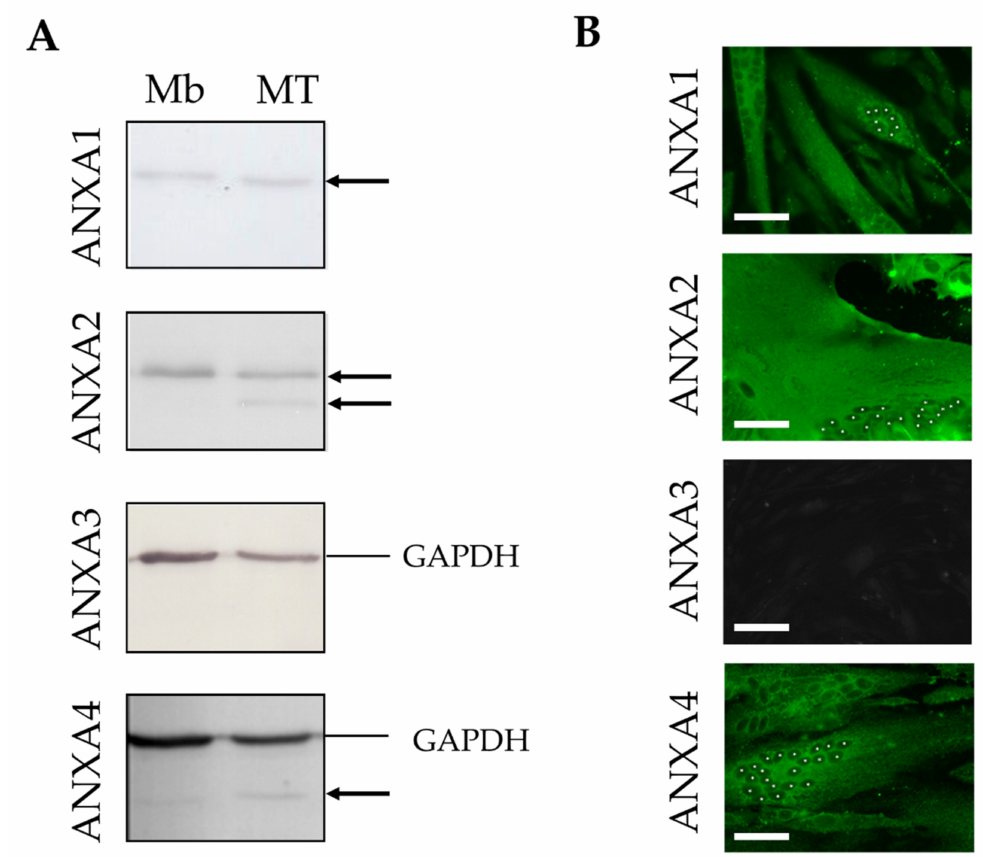
Figure 1. Expression and subcellular distribution of ANX in human myoblasts and myotubes. ( A ) Cellular content in endogenous ANXA1 to A4 in LHCN myoblasts (Mb) and myotubes (MT) was quantified through western blot analysis. Black arrows indicate bands corresponding to ANX. The four western blot experiments were performed simultaneously with the same protein extracts (10 µ